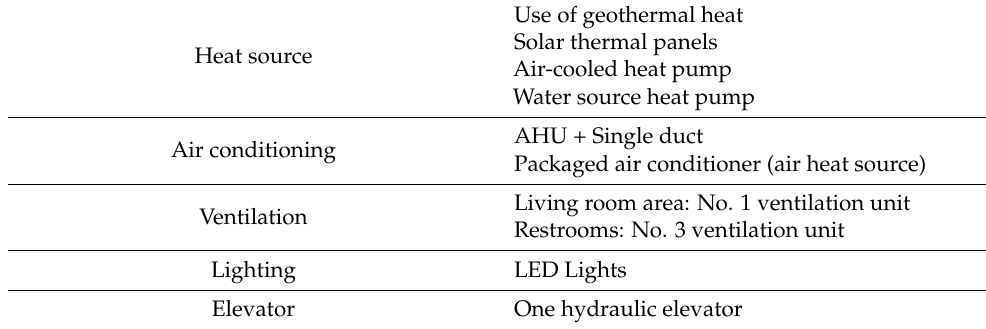
Table 2. Outline of the equipment.